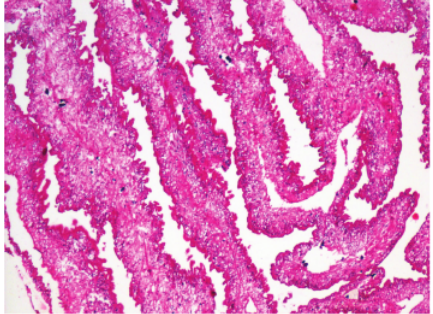
Figure 2: Cysticercus cellulosae (H&E, ×